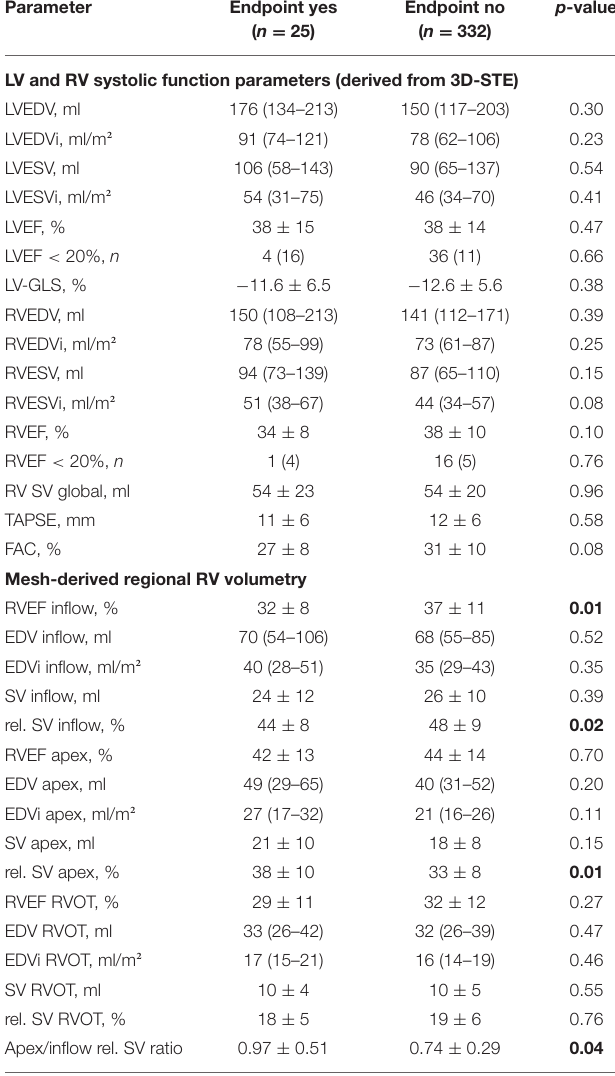
TABLE 2 | Conventional and novel echocardiographic parameters derived from transesophageal echocardiography of patients who reached the endpoint (in-hospital mortality or the need for ECLS) and patients who did not reach the endpoint.